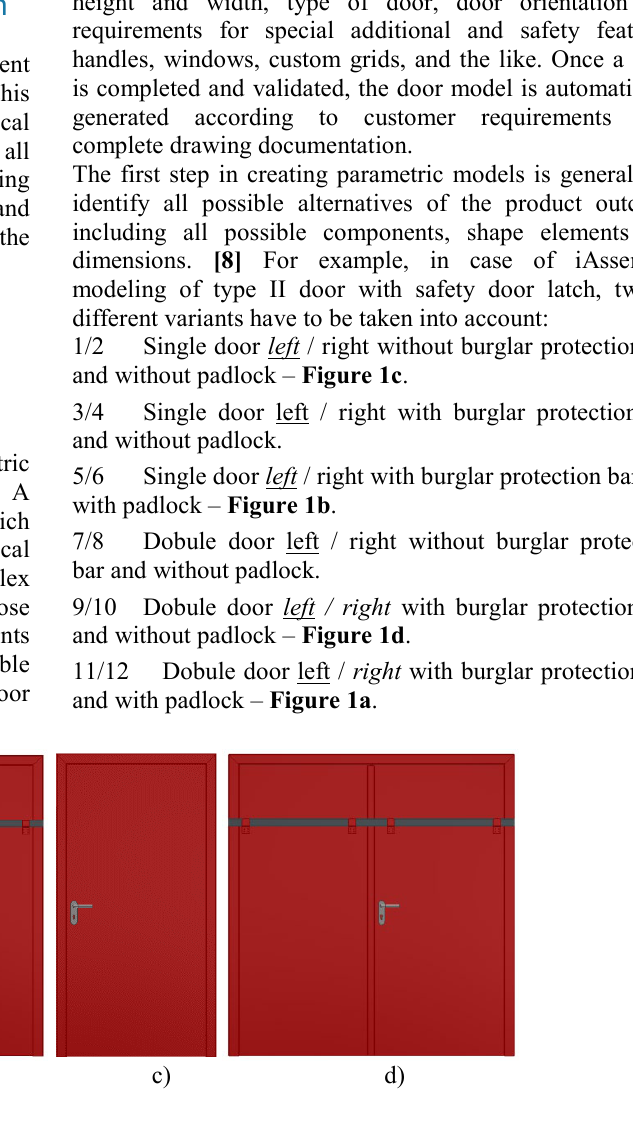
Figure 2 . Design alternatives Type II